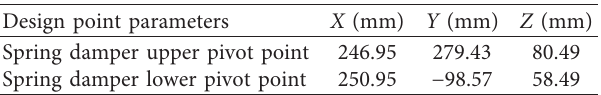
Table 5: Upper and lower pivot point positions of the spring damper.